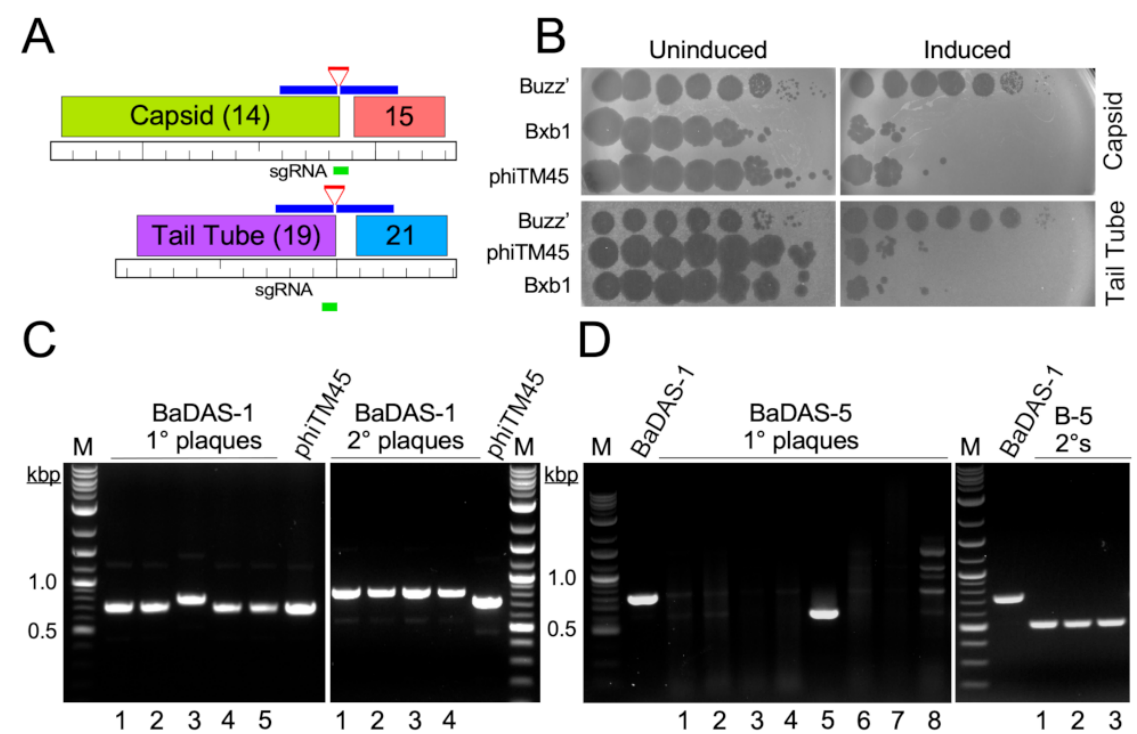
Figure 2. Construction of BaDAS recombinant phages. ( A ) Modification of the Bxb1 capsid and tail tube subunits. Locations of the sgRNA (green line) targeting either the capsid or tail tube subunit genes (gene 14 and 19 , top and bottom, respectively), and the synthetic DNA substrates (blue lines) carrying RBM sequences (red lines) are shown. ( B ) CRISPR-mediated counter selection. Plasmids with inducible expression of Cas9 and sgRNAs targeting the 3 (cid:48) junctions of phage Bxb1 genes 14 or 19 (and its derivative phiTM45) were transformed into M. smegmatis mc 2 155. Cells were plated with or without ATc inducer (as indicated) and 10-fold serial dilutions of Bxb1, phiTM45, and a control phage, BuzzLyseyear, were spotted onto the lawns. sgRNA induction reduces Bxb1 (and phiTM45) plaquing by at least four orders of magnitude. Top panel, targeting capsid gene 14 ; Bottom panel, targeting tail tube gene 19 . ( C ) Primary plaques (left panel) recovered from CRISPY-BRED engineering were screened by PCR using primers flanking gene 14 , and a candidate recombinant (candidate 3) was plaque purified and secondary plaques re-screened by PCR; all candidates are recombinant. ( D ) Primary plaques (left